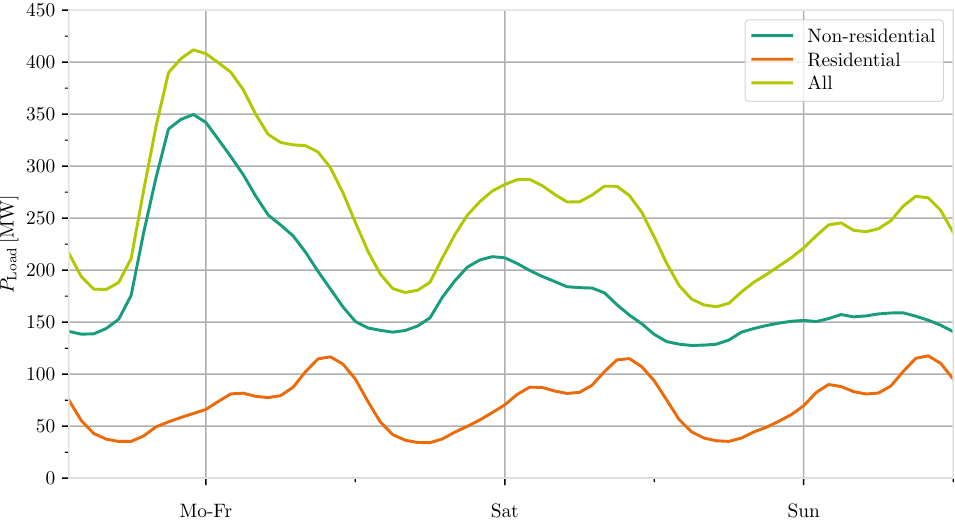
Figure 2. Mean electric load on workdays, Saturdays and Sundays for residential buildings, nonresi- dential buildings and the whole consumption